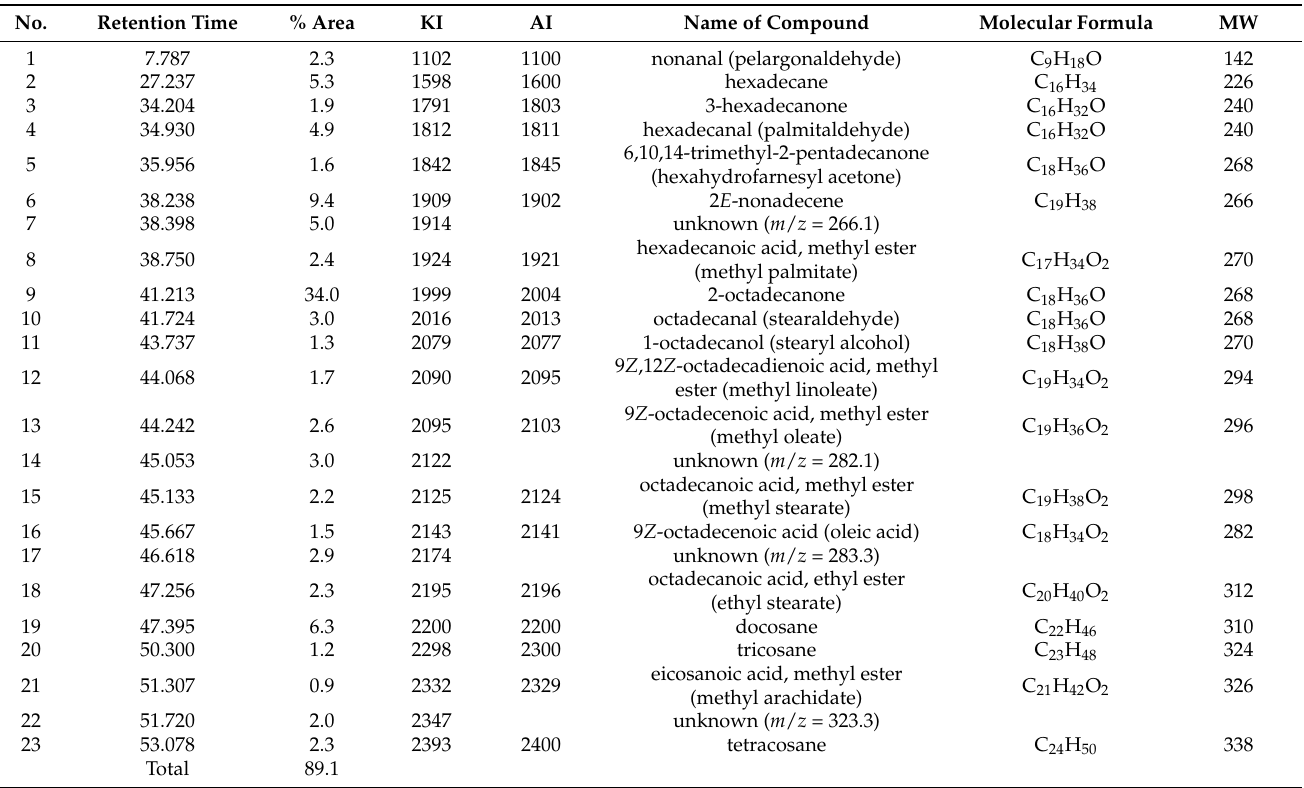
Table 5. Chemical composition of fraction AI.